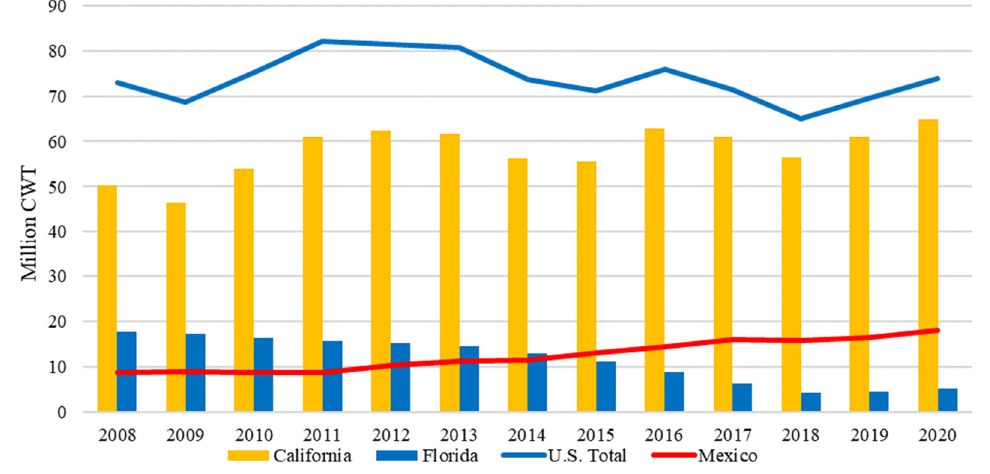
Figure 9. U.S. production and Mexican imports: fresh citrus. Sources: USDA FAS [11]; USDA NASS [37] .